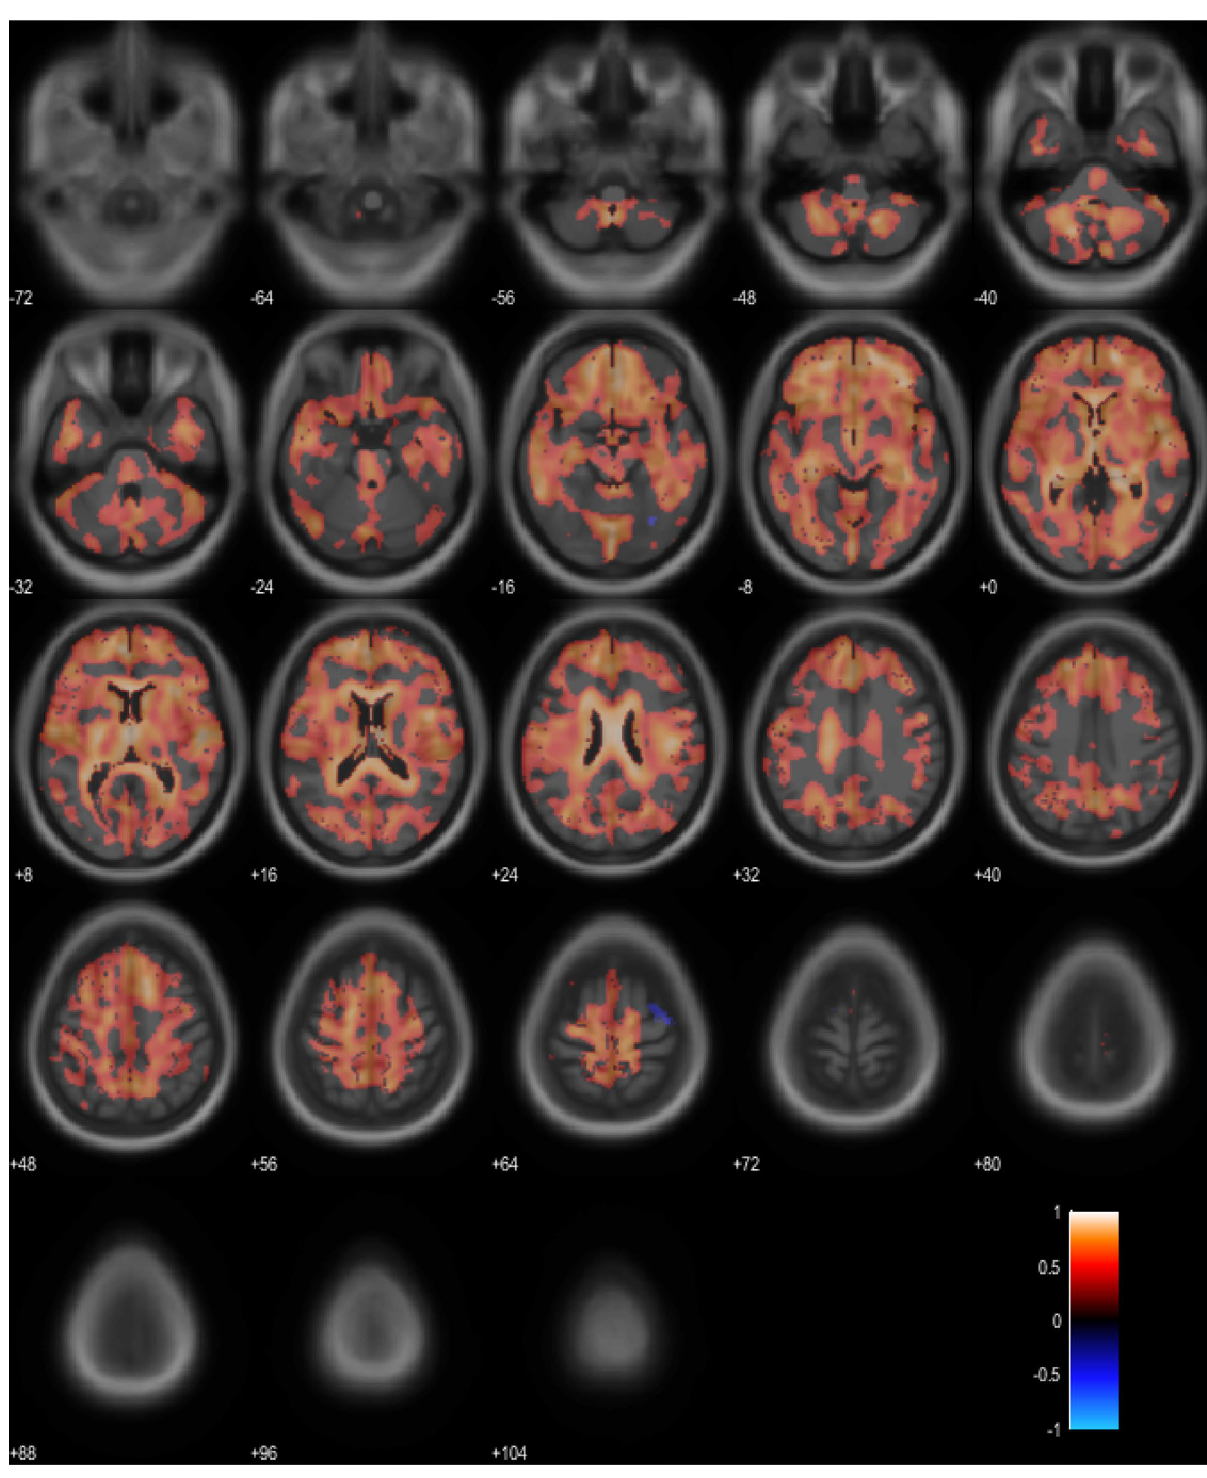
Figure 4. Voxel-wise correlation of eFBB PET and ECD SPECT with normalization by cerebellar grey ( p < 0.05, FDR adjusted). The colored areas overlaid on the T1 weighted MRI template show voxels of significant linear correlation between SUVRs of eFBB PET and ECD SPECT (a). The color bar represents values of Pearson’s correlation coefficient. Abbreviations ECD SPECT, Tc-99m ethyl cysteinate dimer single photon emission computed tomography; eFBB PET, early-phase F-18 Florbetaben positron emission tomography; FDR, False discovery rate; MRI, magnetic resonance image; SUVR, standardized uptake value